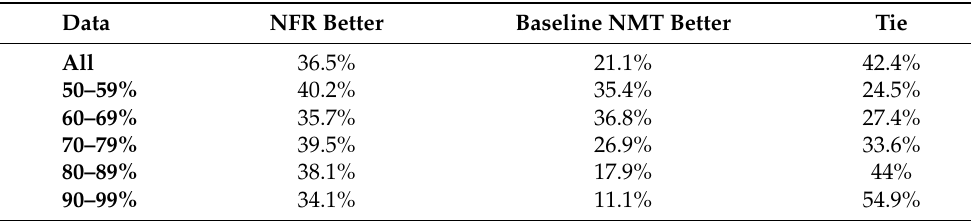
Table A5. Distribution of sentences with better translations per system according to TER, per fuzzy match ratio, including ties, when both systems achieved the same